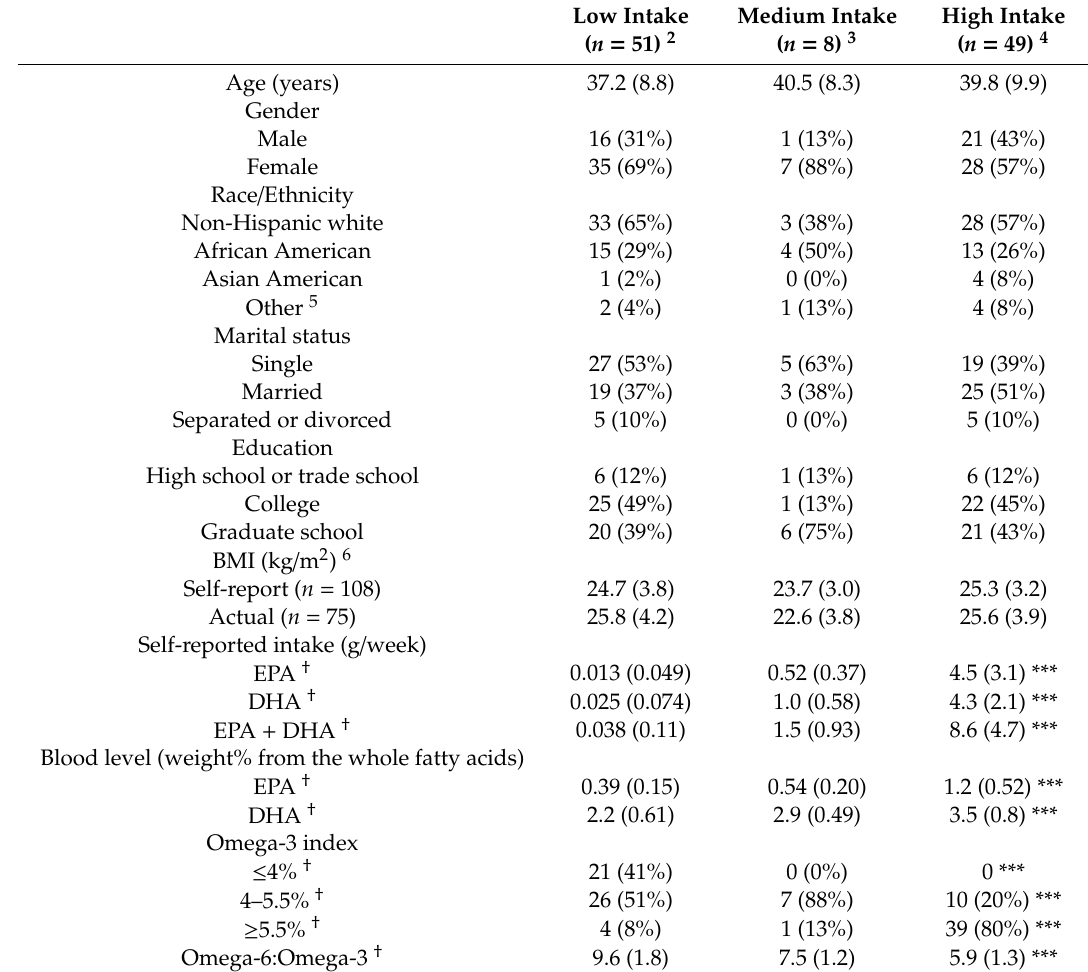
Table 1. Subject characteristics and blood levels of omega-3 fatty acids 1